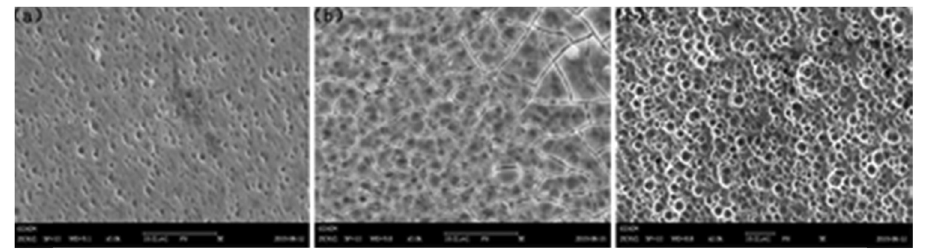
Figure 9: Surface morphology of spanner treated with T liquid for 30 min after anodic oxidation: ( a ) 20 V – 40 min, ( b ) 20 V – 50 min, and ( c ) 20 V – 60 min.